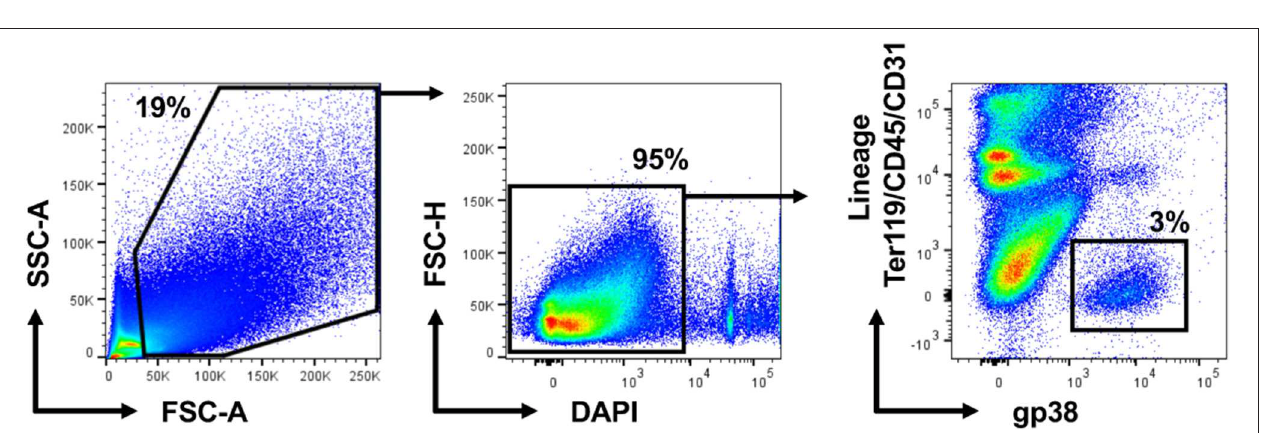
FIGURE 2 | Cardiac Lin − gp38 + represents a distinct stromal cell population in the mouse heart. Representative pictures and quantification of flow cytometry analysis of hearts from wild-type C57BL/6 mice. Mice of mixed gender were sacrificed, hearts were harvested and processed as described in Figure 1 . Cellular debris below 50k in FSC-A were excluded in SSC-A, FSC-A plots. After that, live cells were selected as DAPI-negative in FSC-H/DAPI plots. The percentage of Lin − gp38 + cells was quantified from the population of live cells (gated as DAPI-negative in FSC-H/DAPI plots) ( n =